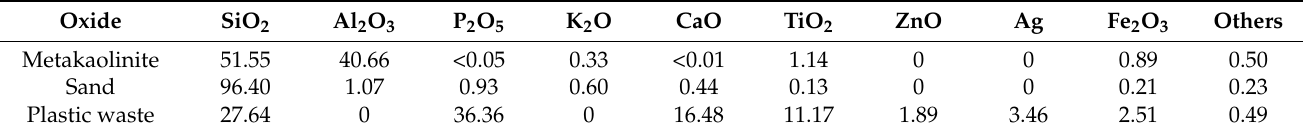
Table 2. Chemical composition of raw materials (Wt%) using the XRF technique.